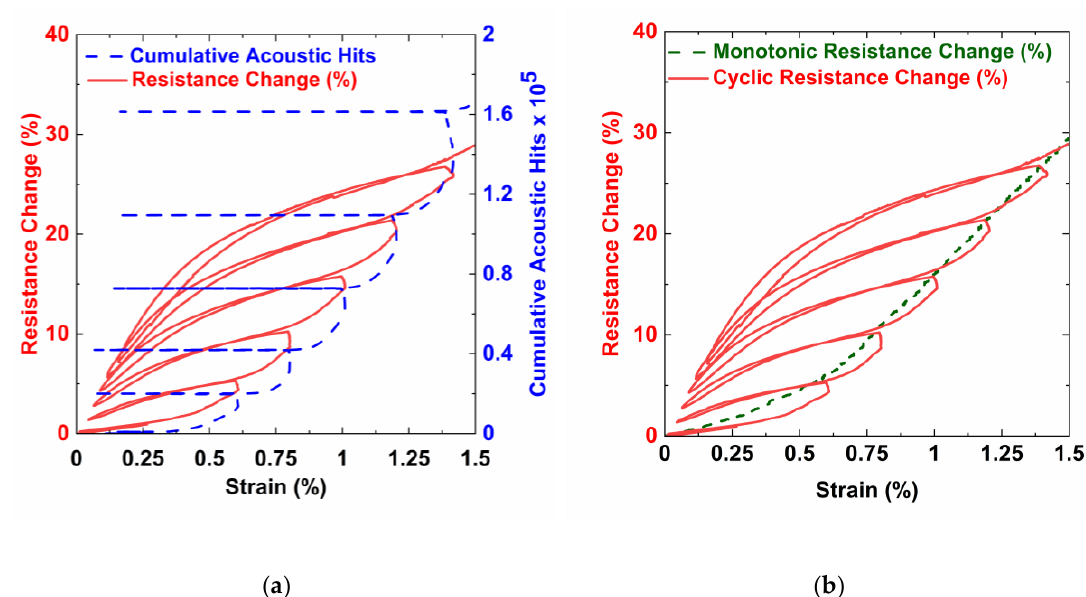
Figure 10. Graphs showing ( a ) resistance and accumulated acoustic hits with strain under cyclic loading and ( b ) comparison of the cyclic and monotonic resistance changes with strain.